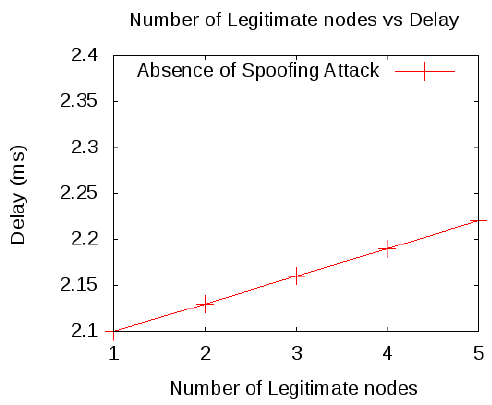
Figure 10. Delay in the absence of spoofing attack.